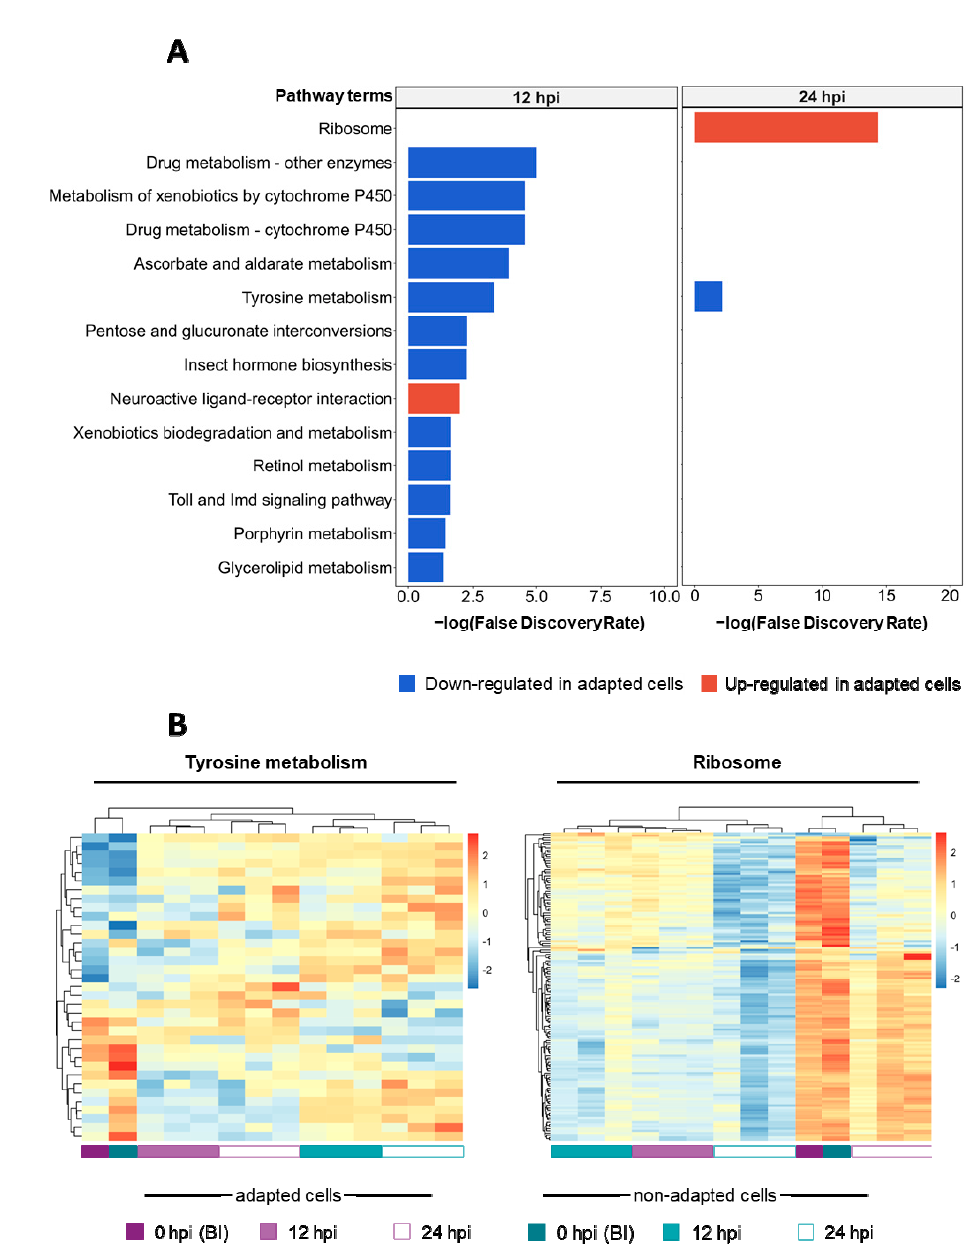
Figure 3. Pathway enrichment analysis. ( A ) Pathway enrichment analysis of differentially expressed genes using Fisher’s exact test. Bar plots indicate enriched terms at 12 and 24 hpi (i.e., longer bars denote pathways more significantly enriched). Color code: red identifies pathways found up-regulated and blue identifies pathways found down-regulated in adapted cells, over non-adapted cells. ( B ) Heat map of tyrosine metabolism pathway and genes encoding for ribosome subunits; the z-score (gradient color code) is defined for all the genes found to be involved in these specific pathways (differentially expressed or not). BI denotes before infection.